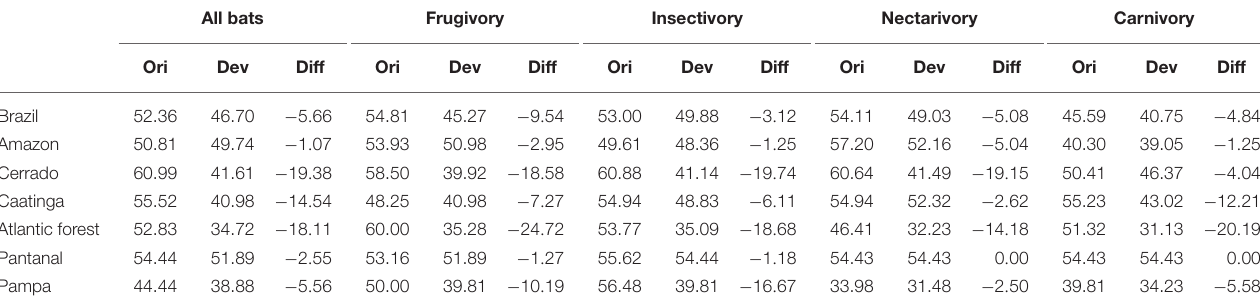
TABLE 3 | Mean value of the ecosystem services index provide by bats considering the original (column ORI) and remaining native (column Dev) in Brazil and biomes. All bats